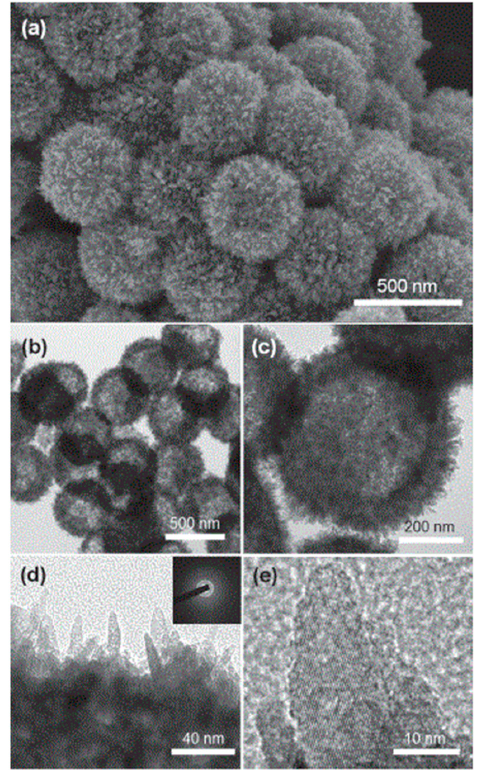
Figure 6. Large-scale synthesis of urchin-like mesoporous TiO 2 hollow spheres (UMTHS) by low- temperature hydrothermal method. SEM ( a ) and TEM (b – e) micrographs of UMTHS obtained